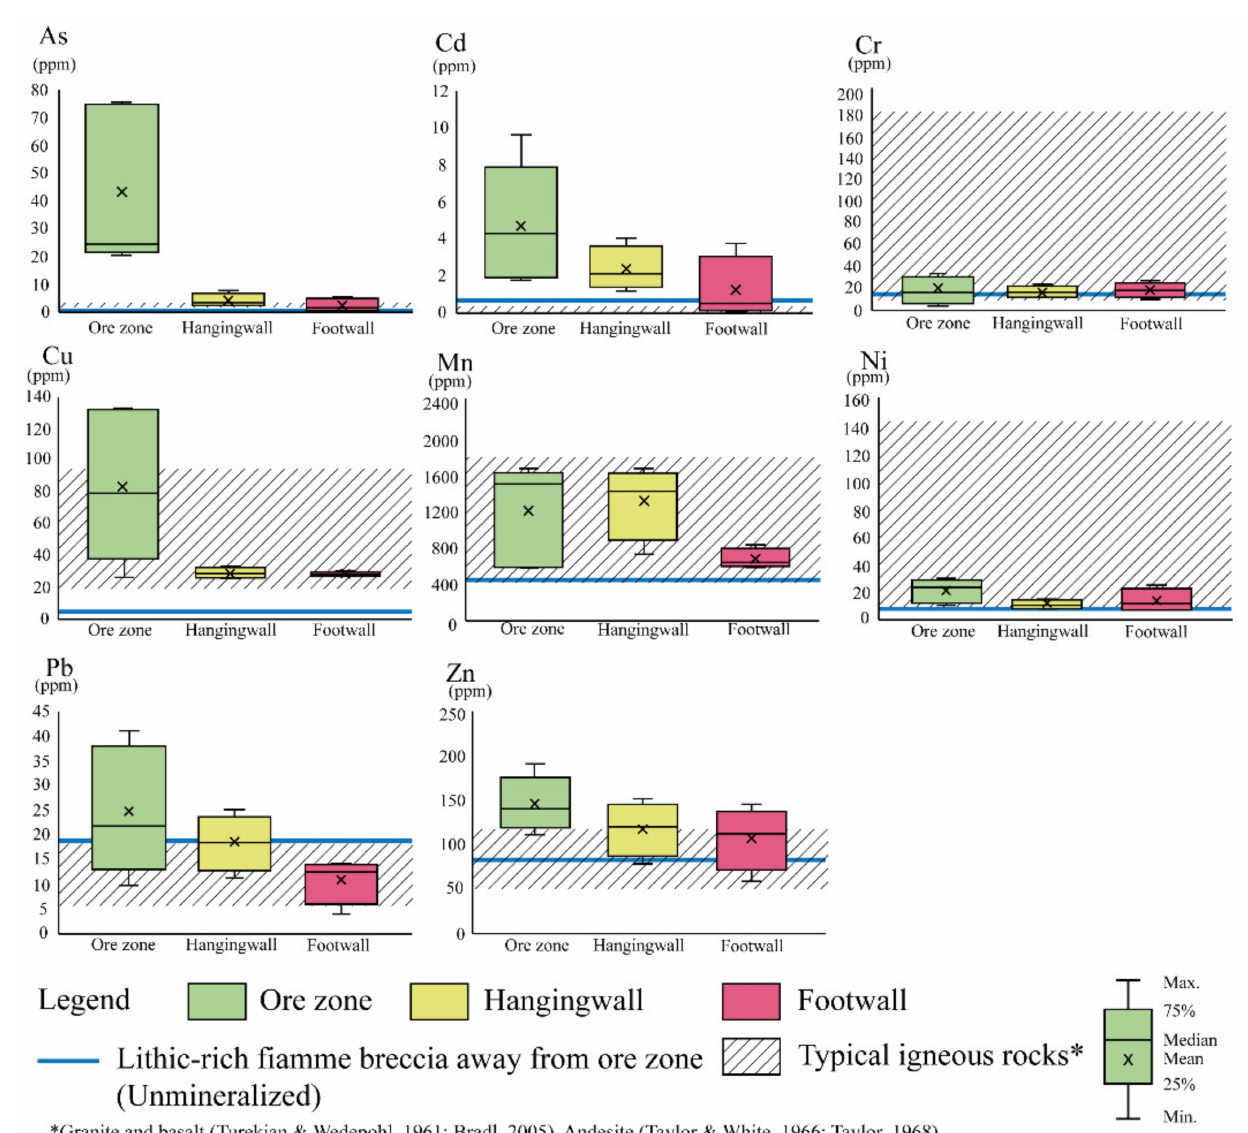
Figure 9. Box and whisker plots of heavy metal contents (e.g., As, Cd, Co, Cr, Cu, Mn, Ni, Pb, Zn) in the samples from ore (n = 5), hanging wall (n = 4), and footwall (n = 4) zones of the H ore lens at the Chatree deposit